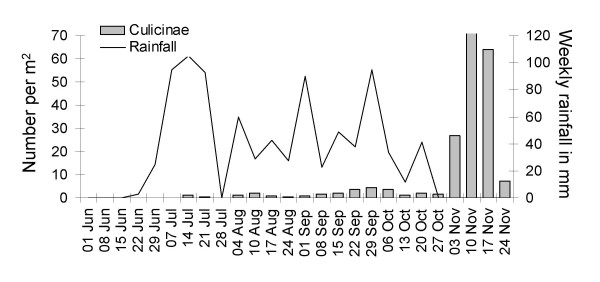
Weekly emergence of culicine mosquitoes per m2 in relation to rainfall pattern.